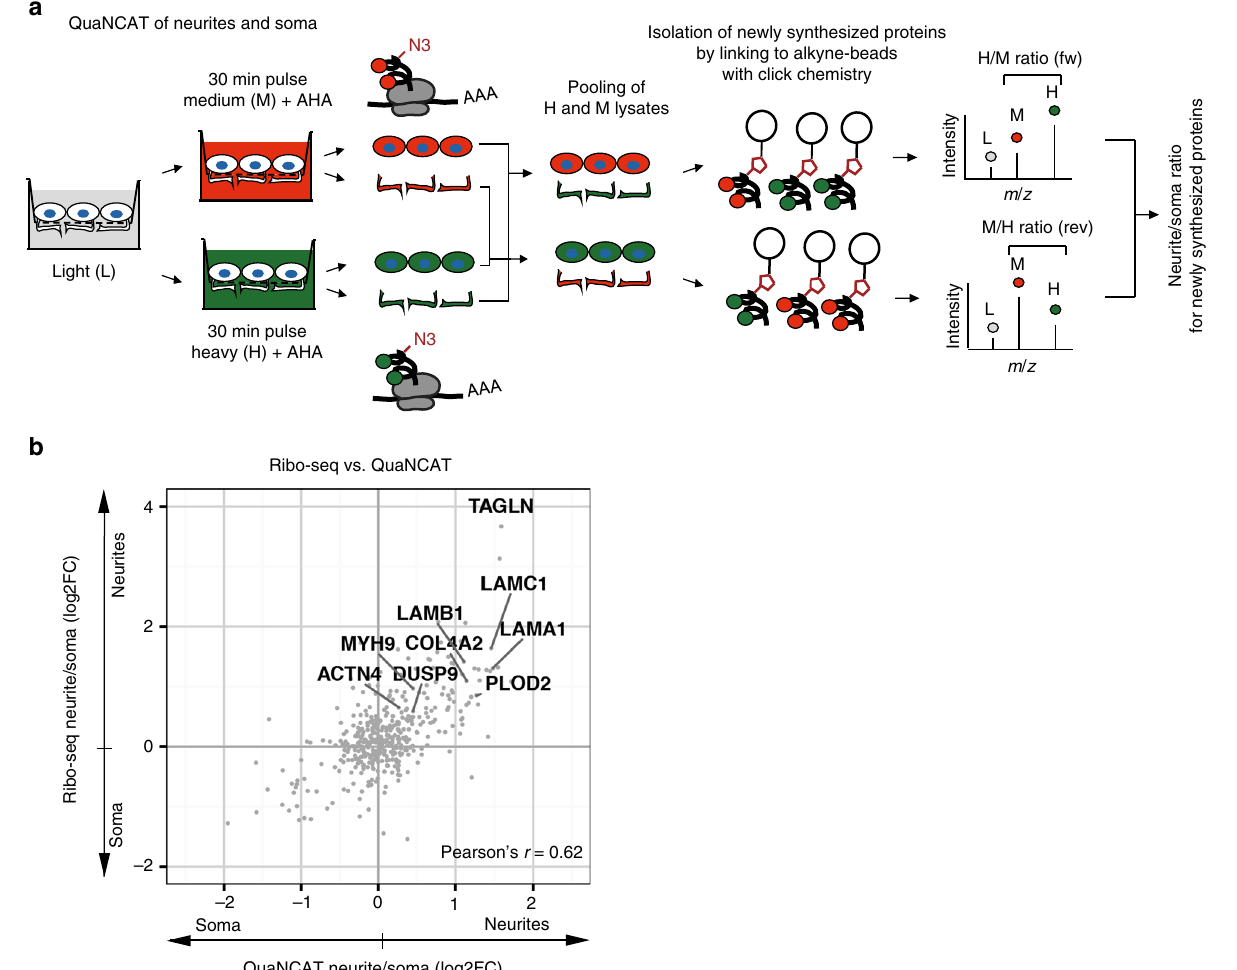
Fig. 4 QuaNCAT of neurites and soma indicates local translation. a Scheme illustrating QuaNCAT of neurites and soma. H / M (forward experiment) and M / H (reverse experiment) ratios for each protein are the measures of neurite/soma translation rates. b Local translation rates measured by Ribo-seq correlate with QuaNCAT measurements. Averaged neurite/soma QuaNCAT ratios plotted against enrichment of Ribo-seq reads in